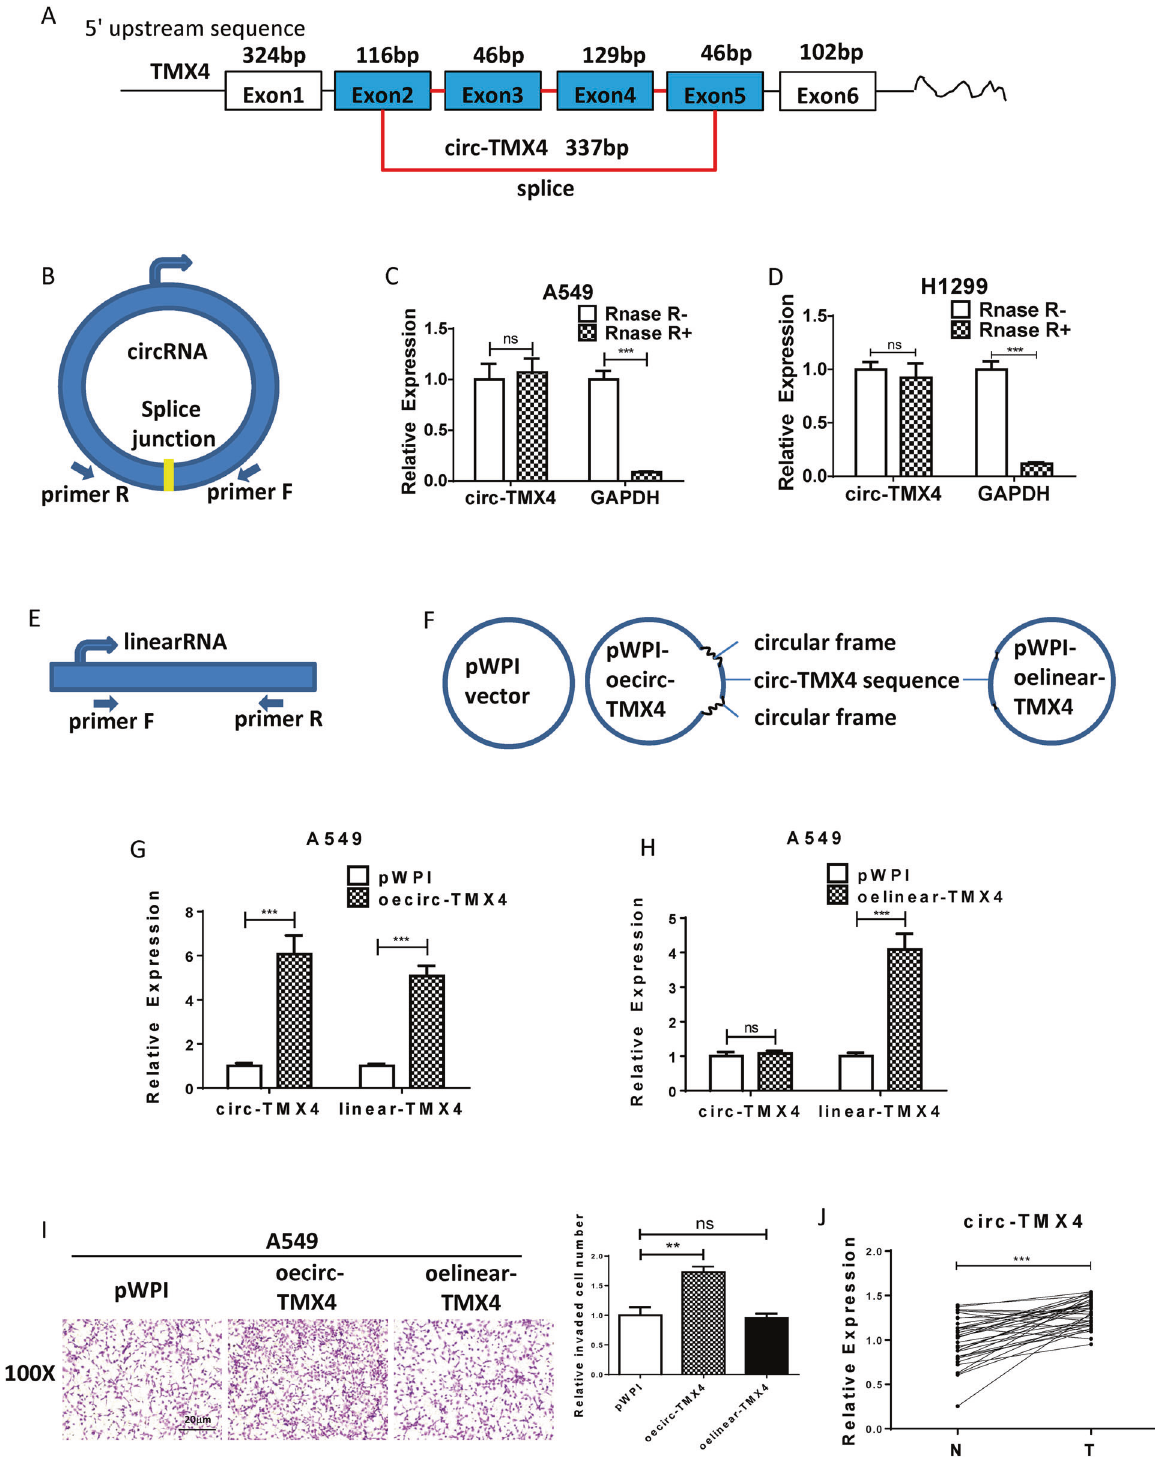
Fig. 2 Circ-TMX4 promotes lung cancer cell invasion. A The schematic diagram shows the genomic location and splicing patterns of circ- TMX4 (hsa_circ_0001130). B The schematic diagram shows the divergent primers covered splice junction to detect circ-TMX4. C , D The expression of circ-TMX4 and GAPDH mRNA in A549 and H1299 cells treated with or without RNase R was detected by qRT – PCR. E , F The schematic diagram shows the divergent primers without covered splice junction to detect both linear-TMX4 and circ-TMX4. G , H qRT-PCR assay was used to verify the effect of oecirc-TMX4 and oelinear-TMX4. I Chamber-transwell invasion assay was used to check the invasion capacity after adding circ-TMX4 and linear-TMX4 in A549. J The expression of circ-TMX4 in fresh lung cancer tumor tissues (T) and paratumor normal tissues (N) was detected by qRT – PCR. All quantitations are presented as mean ± SD and p values calculated by t -test, ** p < 0.01, *** p < 0.001, ns = not signi fi cant.